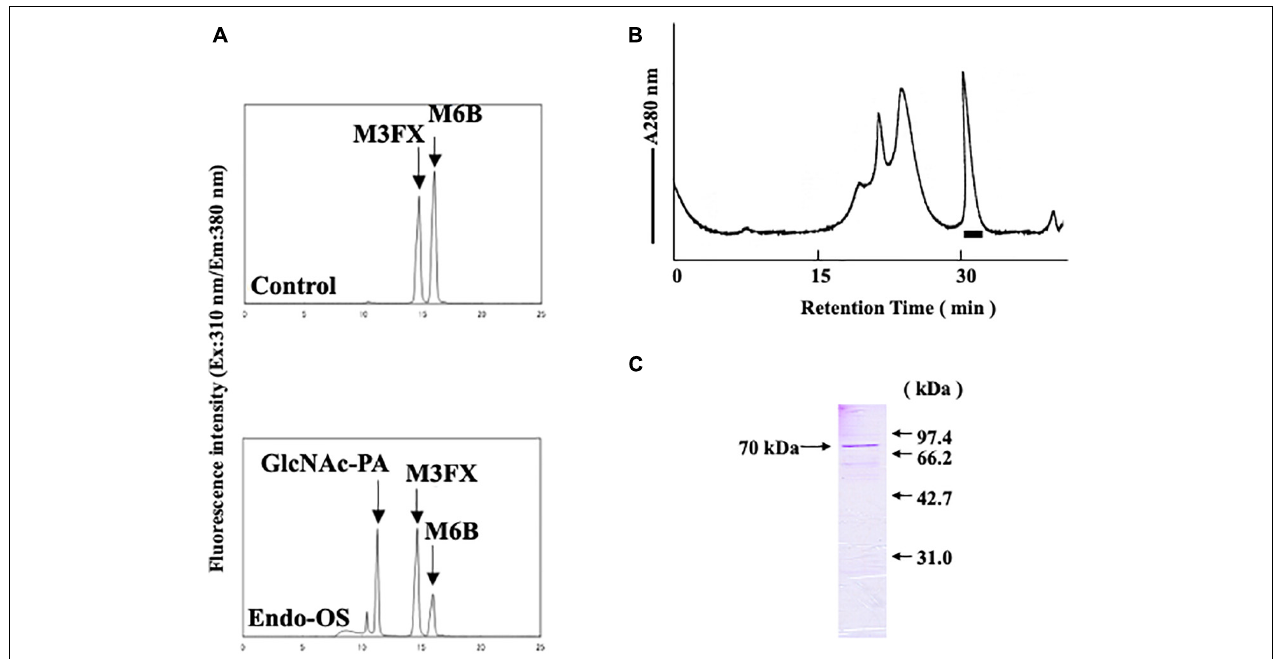
FIGURE 1 | Final purification and SDS-PAGE of the Endo- β -GlcNAc-ase. (A) Assay of endo- β -GlcNAc-ase activity on RP-HPLC; (B) partially purified endo- β -GlcNAc-ase was applied to the Tsk-Gel G3000SWXL column (7.8 × 600 mm) equilibrated with 25 mM MES at pH 6.7, containing 5 mM of EDTA, 5 mM of DTT, and 0.15 M NaCl, and eluted with the same buffer at a flow rate of 0.5 mL/min. The bar indicates endo- β -GlcNAc-ase activity; and (C) proteins were separated using SDS-PAGE on a 15% acrylamide gel under reduced conditions with 5% 2-mercaptoethanol. Proteins on the gel were stained with Coomassie Brilliant Blue